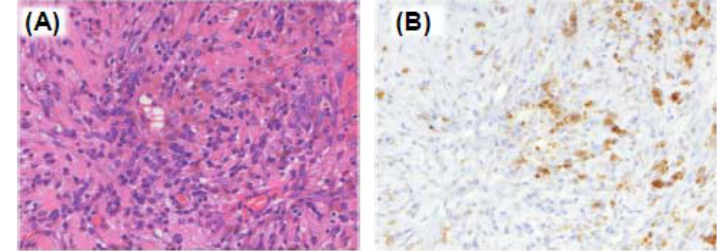
Figure 3. Cancer stroma. ( A ) Endometriosis. The ovarian stroma is infiltrated by numerous hemosiderine-laden macrophages, lymphocytes and plasma cells; ( B ) CD68